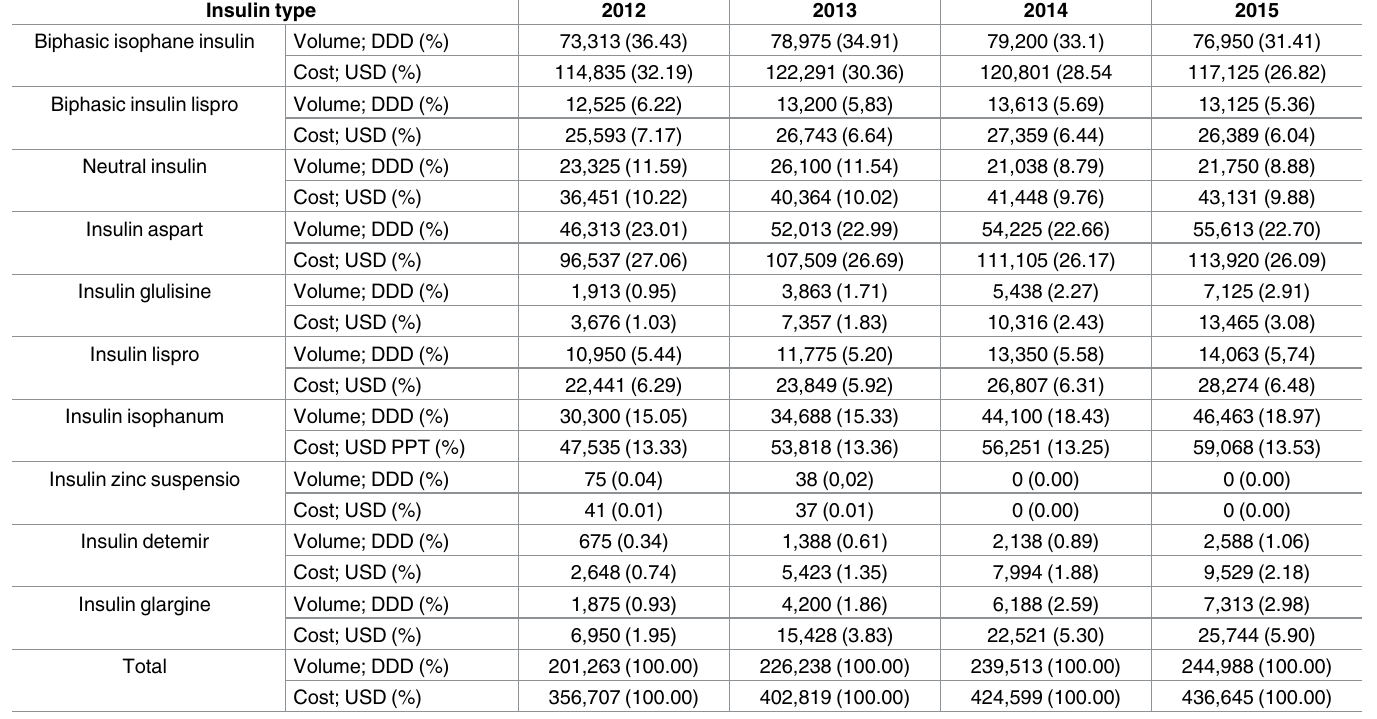
Table 2. Volume and cost of insulins by insulin type in Poland. Number of DDDs in thousands.Costs in USD x 1000.